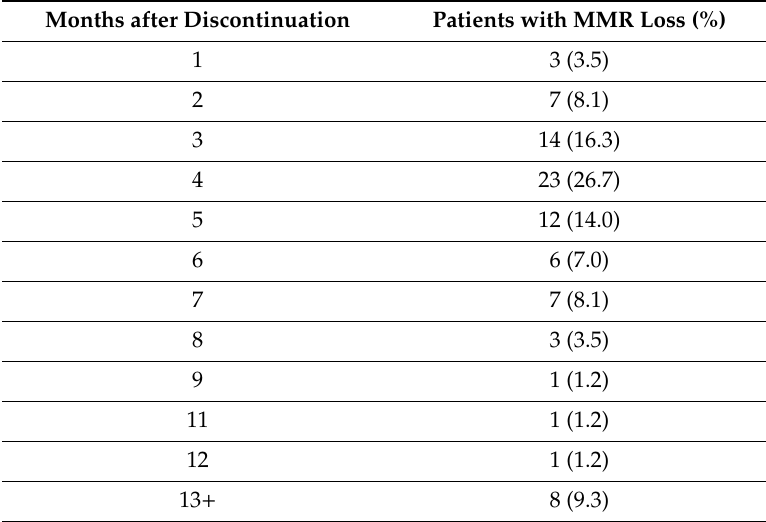
Table 1. A panoramic of major molecular response (MMR) loss month by month. Percentages refer to the total number of relapses. Months after Discontinuation Patients with MMR Loss (%)